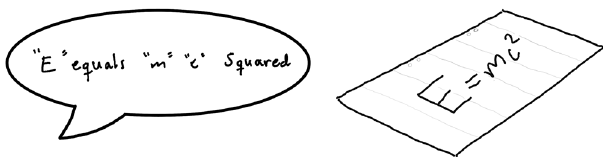
FIG. 3. Two semiotic representations of the same underlying mathematical object. Both semiotic representations are part of the same semiotic register: the algebraic register. On the left is the spoken form and on the right is the written form of the algebraic register.